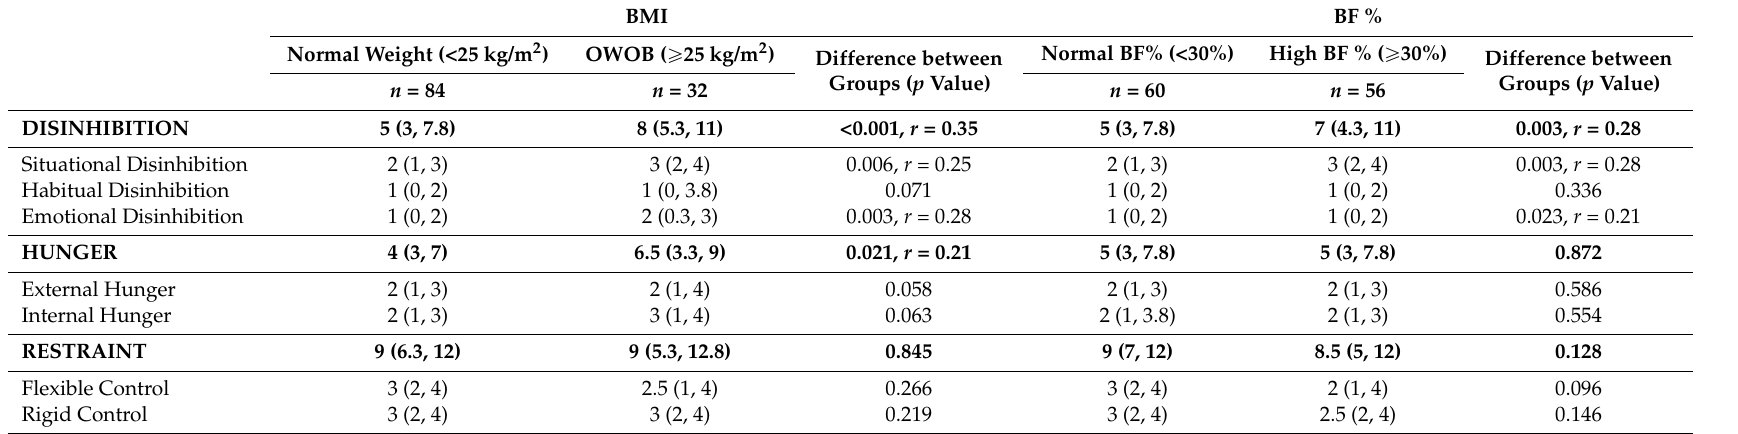
Table 4. Exploration of Disinhibition and sub-categories in relation to BMI and BF %